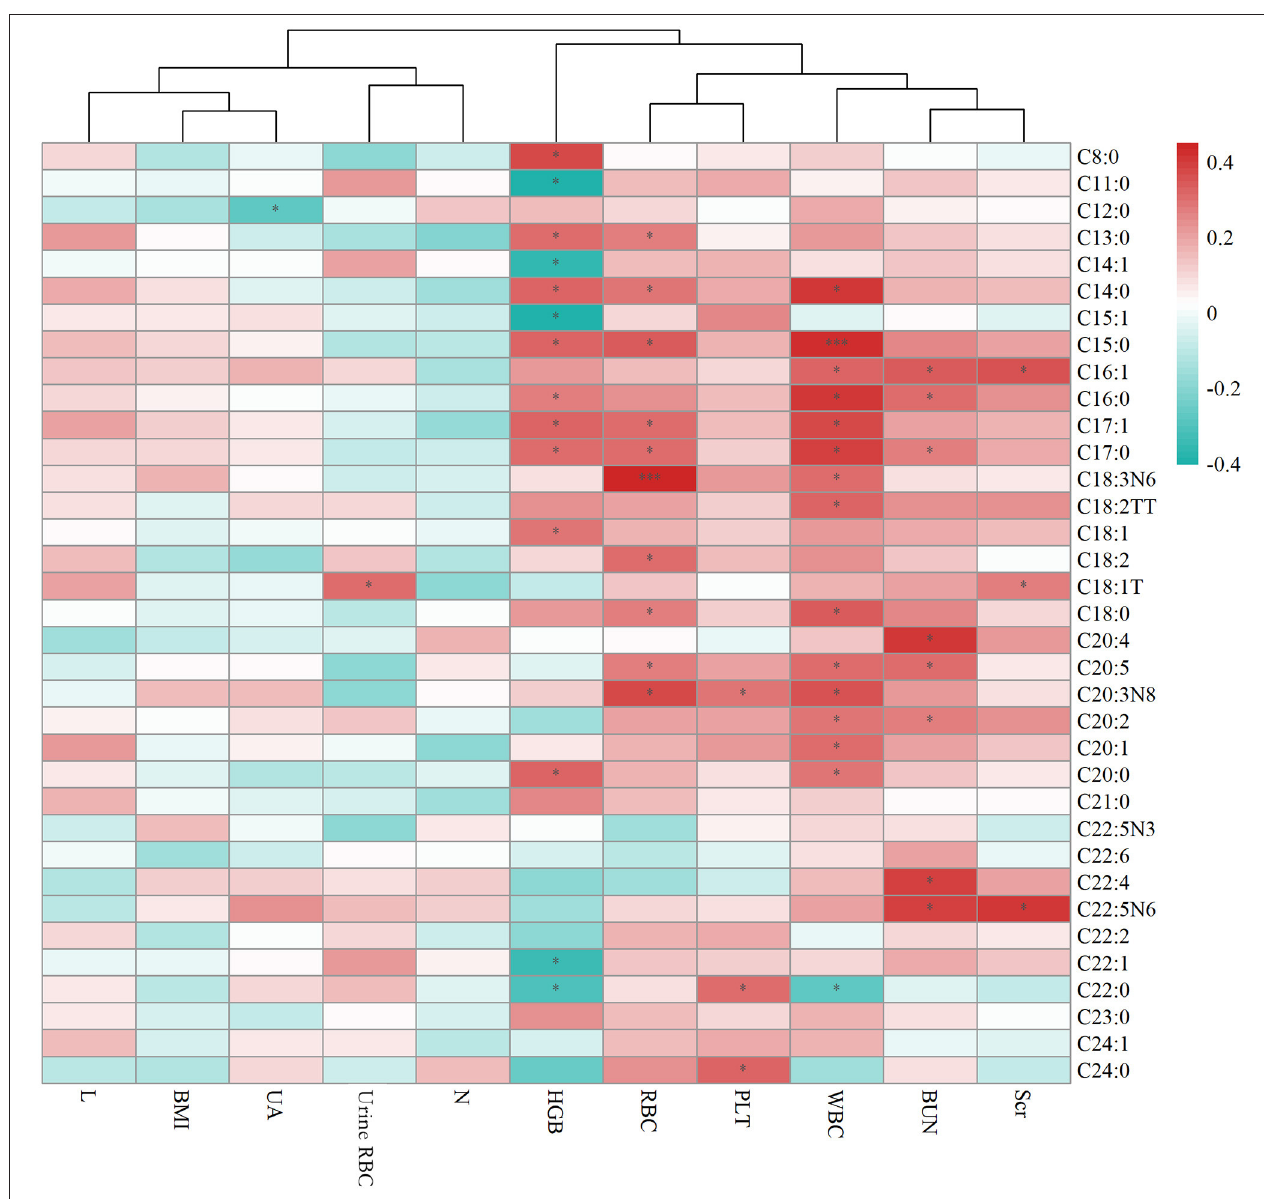
FIGURE 2 | Heat map summarizing the correlation between serum fatty acids and laboratory test results of HSP. Scr means Serum creatinine (umol/l), BUN means Blood urea nitrogen (mmol/l), UA means Uric acid (umol/l), WBC means White blood cell (10 9 /l), RBC means Red blood cell (10 12 /l), PLT means Platelet (10 9 /l), HGB means Hemoglobin (g/l), N means the percent of Leukocyte, L means the percent of Lymphocyte, BMI shows Body Mass Index. * means p < 0.05, *** means p < 0.001.